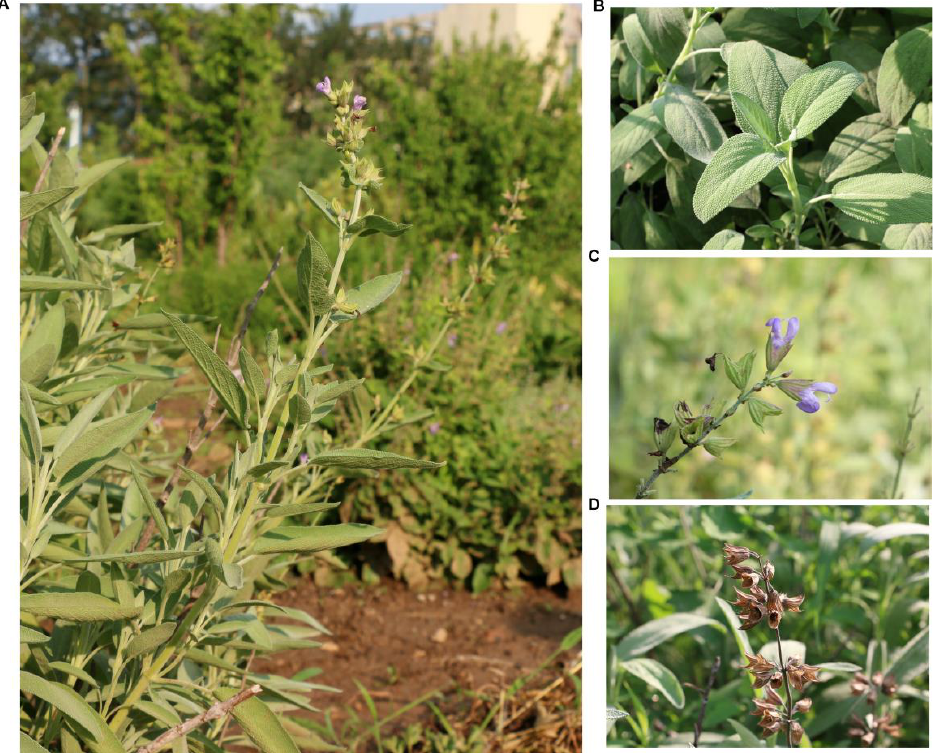
Figure 1. Photographs of the aerial parts of S. officinalis . The images were photographed by Dr. Xinlei Zhao from the Institute of Medicinal Plant Development, Chinese Academy of Medical Sciences, Beijing, China, and are used in this study with permission. ( A ) The entire plant; ( B ) the leaves; ( C ) the flowers; and ( D ) the fruits and seeds.